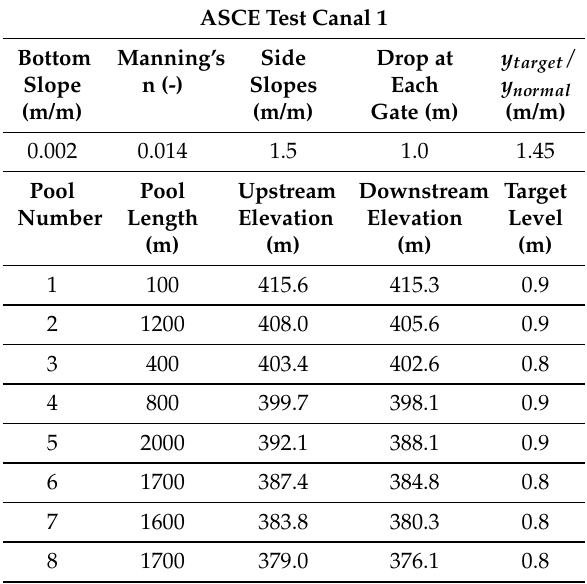
Table 1. Properties and characteristics of the ASCE Test Canal 1.